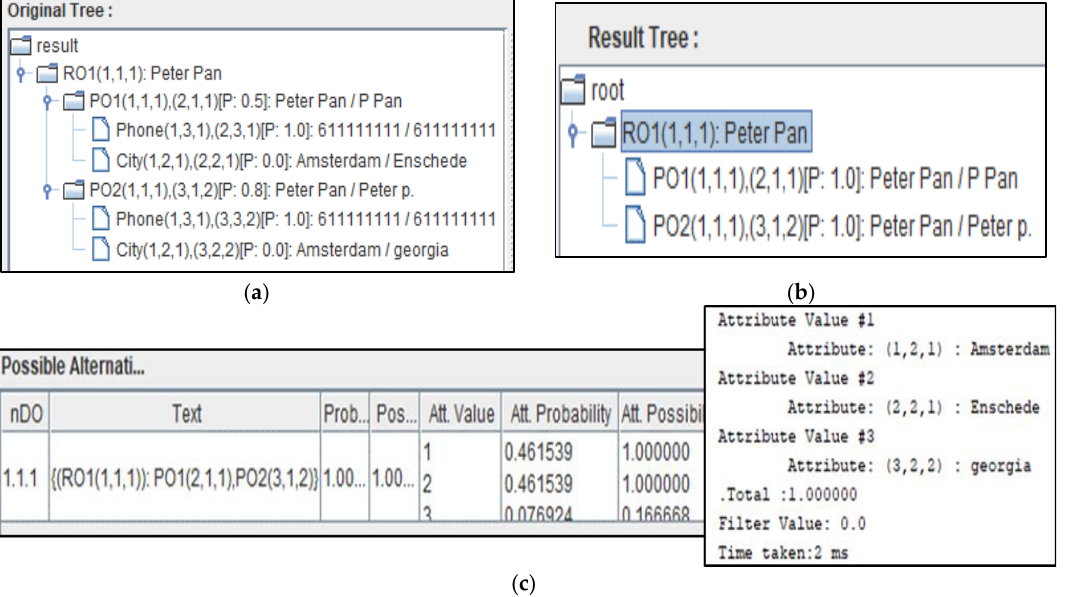
Figure 5. City data fusion alternatives’ example with their updated reliability score based on the C2.1.1 case. ( a ) The participated entities with their original matching tree. ( b ) The probabilistic entities linkage/merging results. ( c ) The possible data fused values for City attribute at each possible entities merging alternative as produced based on Figure 5b.